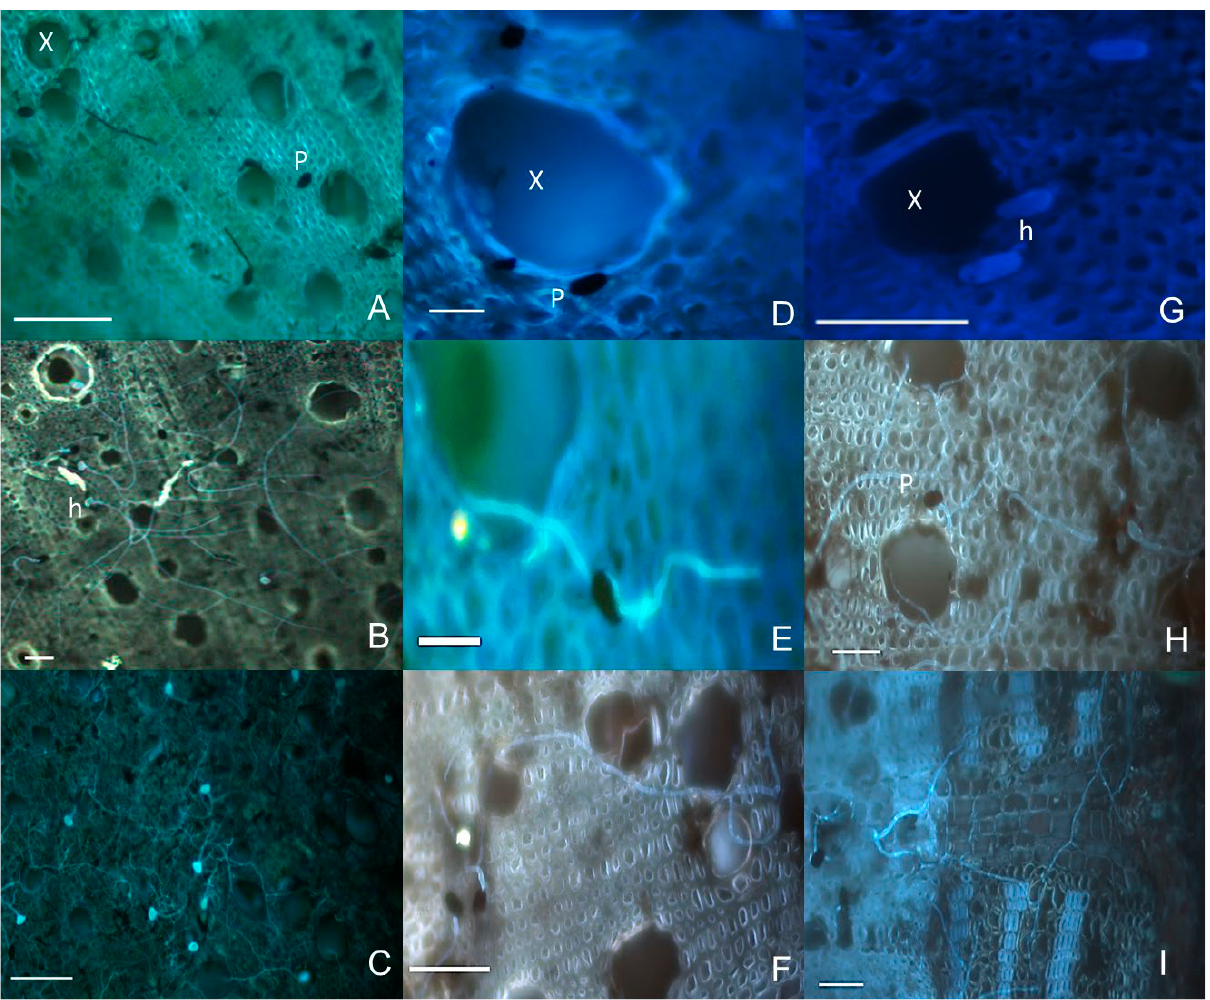
Figure 6. Transverse sections of grapevine stems inoculated with pycnidiospores of Lasiodiplodia gilanensis (A, B and C), Diplodia seriata (D, E, and F) or D. corticola (G, H and I), observed under epifluorescence microscopy at 12 h (A, D and G), 24 h (B, E and H) or 48 h (C, F and I) after inoculation with these fungi. Greater hyphal branching and colonization was observed in stems inoculated with L. gilanensis. X) xylem vessel; h) hyaline pycnidiospores; p) pigmented pycnidiospores. Bars = 50